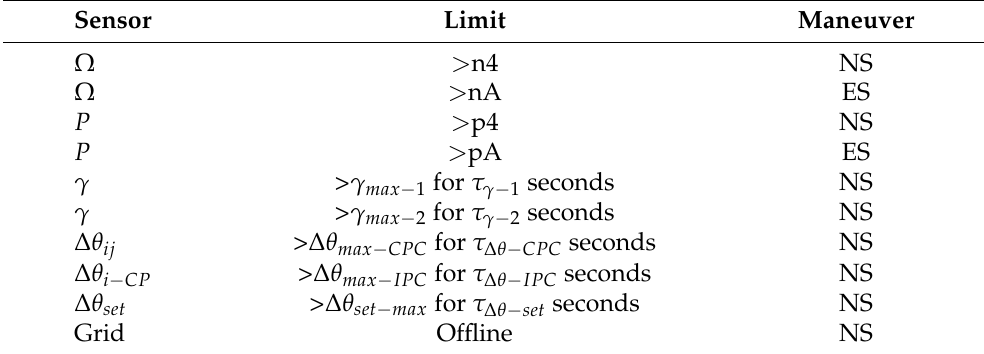
Table 1. Limits and reaction maneuvers of the supervisory control. Depending on the pitch